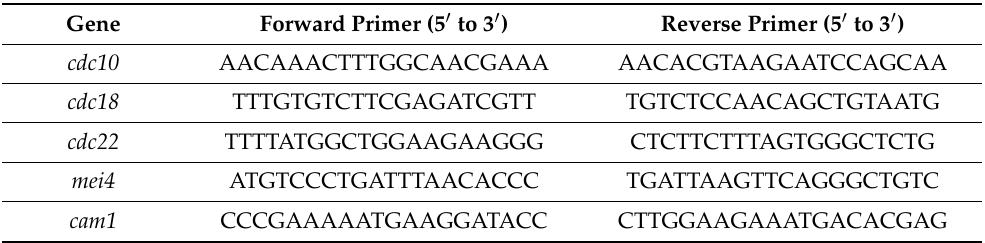
Table 2. List of primers used for Reverse-transcription Quantitative Real-Time PCR (RT-qPCR).